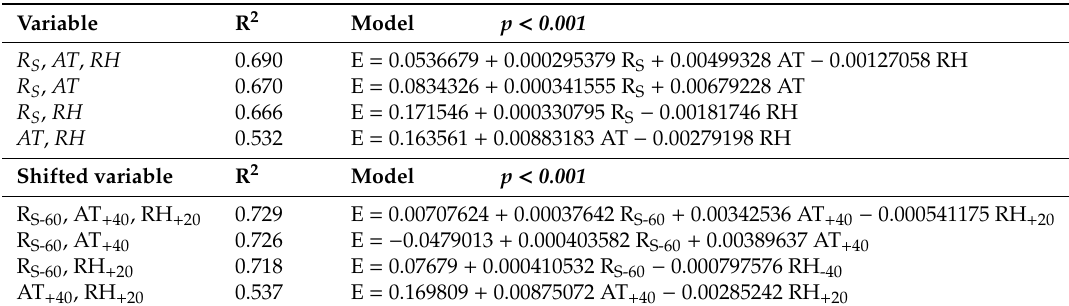
Table 4. Results of fitting a multiple linear regression model to describe the relationship between stand transpiration and global radiation ( R S ), air temperature ( AT ) and relative humidity ( RH ) as independent variables (variables without time shift: top, variables shifted in time: bottom).